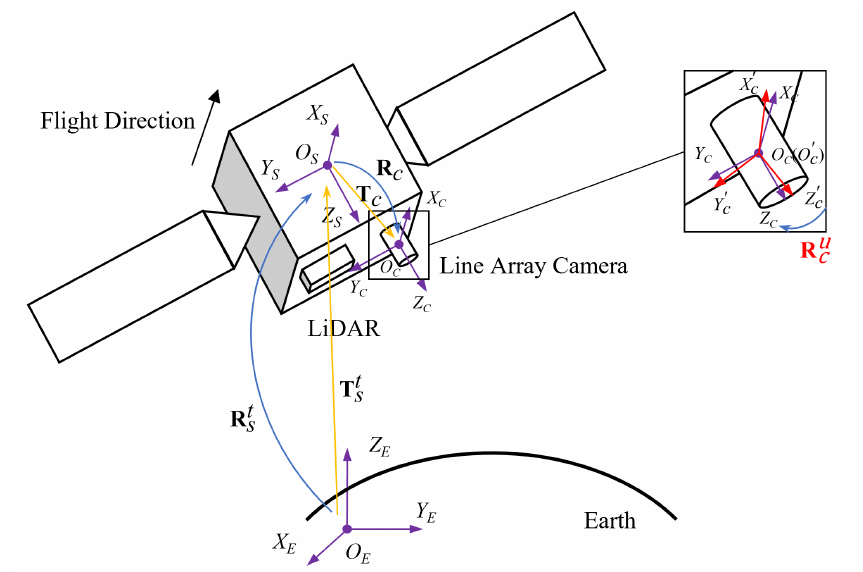
Figure 2. The geometric meaning of the matrices of the imaging model of the line array camera.